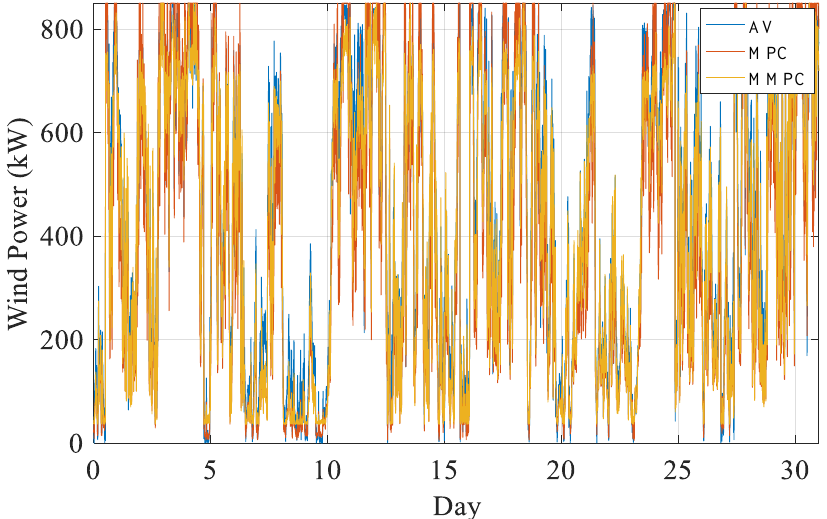
Figure 11. Comparison of wind power output during the month.